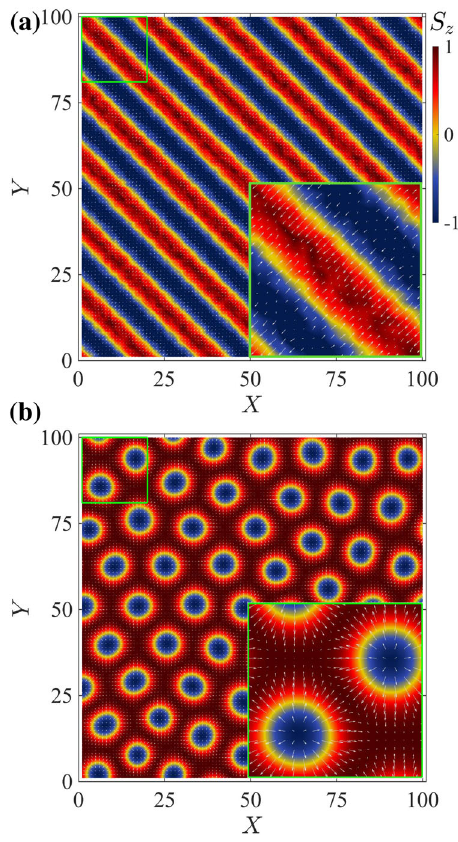
Fig. 1 Spin textures in the spin spiral (SS) and the skyrmion crystal (SkX) phases. The spin textures were spontaneously generated in the Monte Carlo annealing process in a 100 × 100 square lattice with periodic boundaries: a SS texture realized at zero magnetic fi eld ( H z = 0), b nearly- triangular crystal of skyrmions realized at a magnetic fi eld H z = 0.18 J ( ≈ 3.74 T). Parameters used are ferromagnetic exchange interaction strength J = 1, spin amplitude S = 3/2, Dzyaloshinkii – Moriya interaction strength D = 0.5 J , easy-plane anisotropy amplitude A = 0.01 J and temperature T = 0.001 J ( ≈ 14 mK). The white arrows and the colorbar respectively show the in-plane ( x and y ) components and the perpendicular ( z ) component of the spins. The insets show an expanded view of the spin con fi guration inside the region denoted by the green square on the top-left fi elds, fi rst at a low temperature T = 0.001 J and then discuss the high-temperature diffusive regime in which the liquid-crystal transition takes place. The SS phase, which is stabilized at zero magnetic fi eld, evolves into a triangular SkX within a range of magnetic fi elds and fi nally becomes a fully-polarized FM phase at higher fi elds. A detailed analysis of the phase diagram, spanned by the magnetic fi eld and the temperature, was done in our previous work 39 . In Fig. 1a, b, we show the spin con fi gurations of the SS phase and the SkX phase, obtained in a typical annealing session of the Monte Carlo simulations, respectively at zero fi eld ( H z = 0) and at a fi nite fi eld ( H z = 0.18 J ). Since the DM vectors lie pre- dominantly at the interface plane, the SS and the SkX textures are Néel-type in nature, unlike in three-dimensional chiral magnets such as MnSi in which out-of-plane DM vectors lead to Bloch- type textures. A change in the sign of D reverses the sense of rotation of the spins in going from the skyrmion center towards the radially outward direction. At the considered DMI strength D = 0.5 J , which is close to the value realizable at oxide inter- faces 49 – 51 , the period of the SS and the skyrmion diameter are